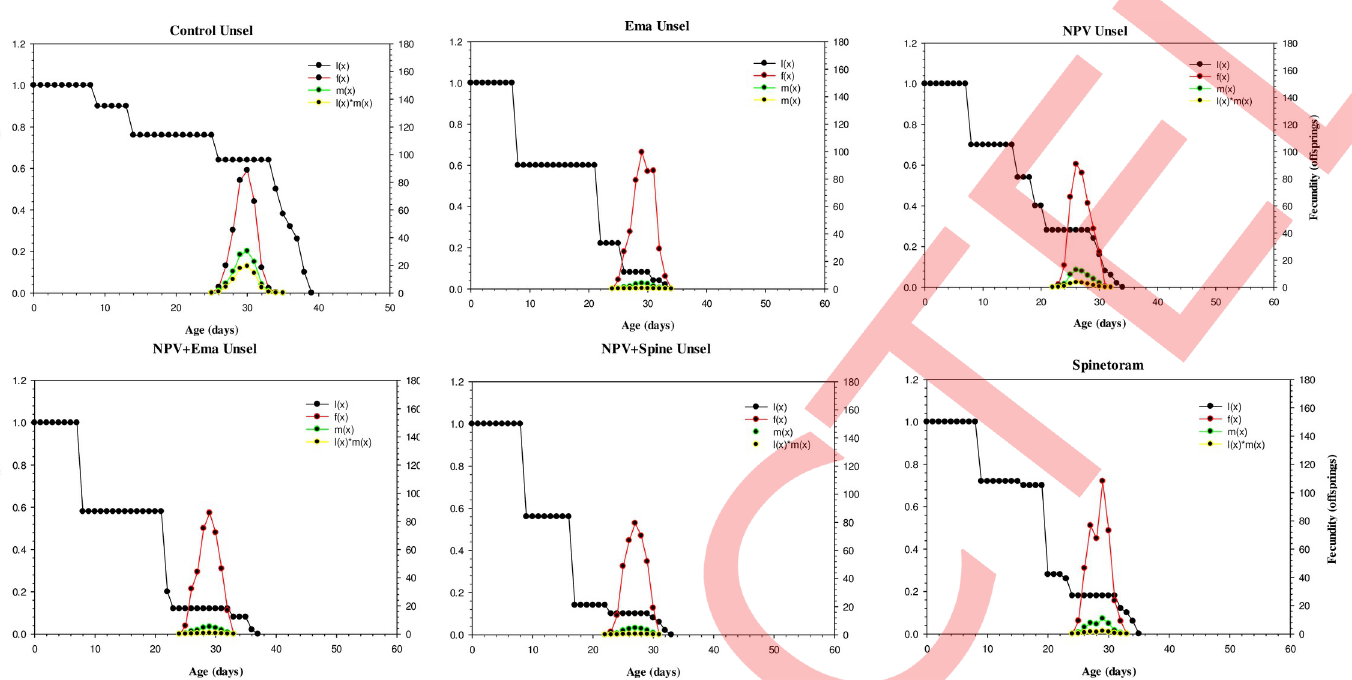
Fig 5. Effect of HaNPV, insecticides and their combinations on age-stage specific survival (lx), age stage specific maternity (mx) and their product in emamectin benzoate selected population of Helicoverpa armigera .